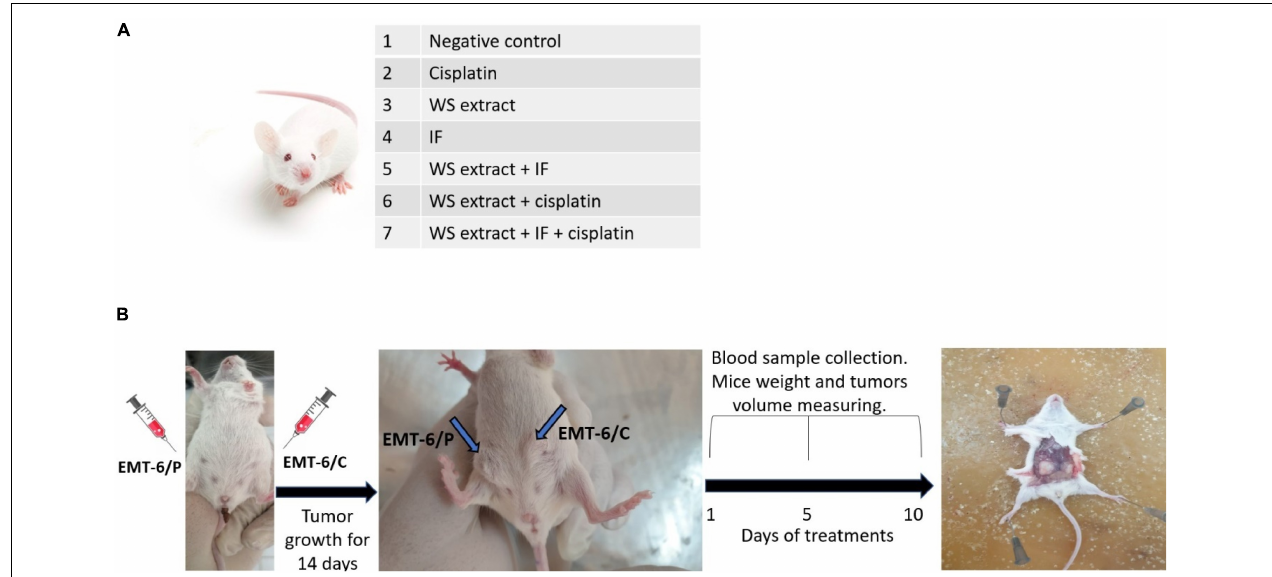
FIGURE 2 | In vivo mice study. (A) Groups of cisplatin-sensitive (EMT6/P) and cisplatin-resistant (EMT6/CPR) inoculated mice. Treatments were: WSR extract (100 mg/kg/d) by gavage, a daily 18 h of intermittent fasting (IF) and 6 h of eating or/and cisplatin (5 mg/kg/week) by intraperitoneal injections for 10 days. (B) Scheme for mice experiment ( n =